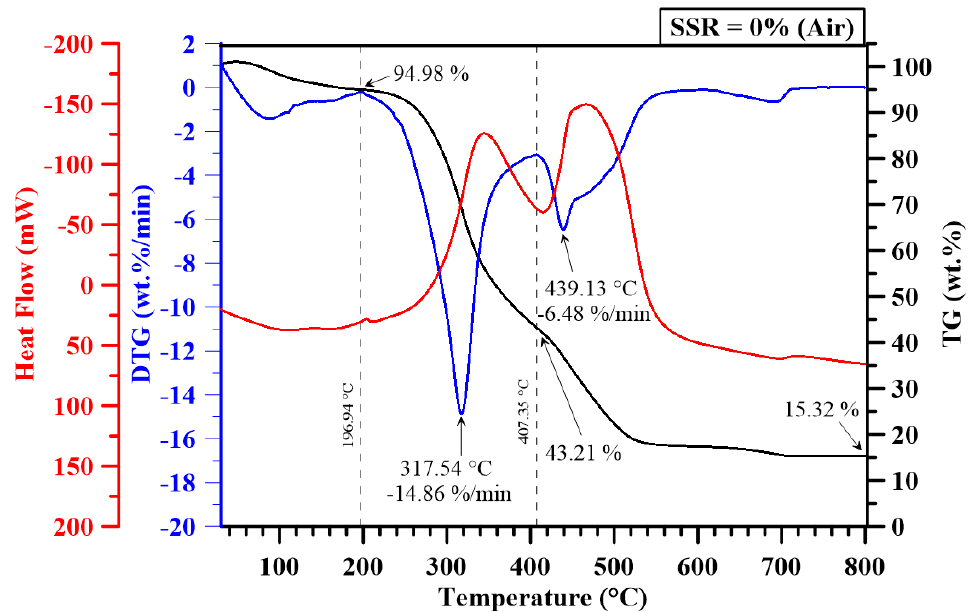
Figure 5. Thermogravimetric analysis results of shiitake substrate under combustion condition.